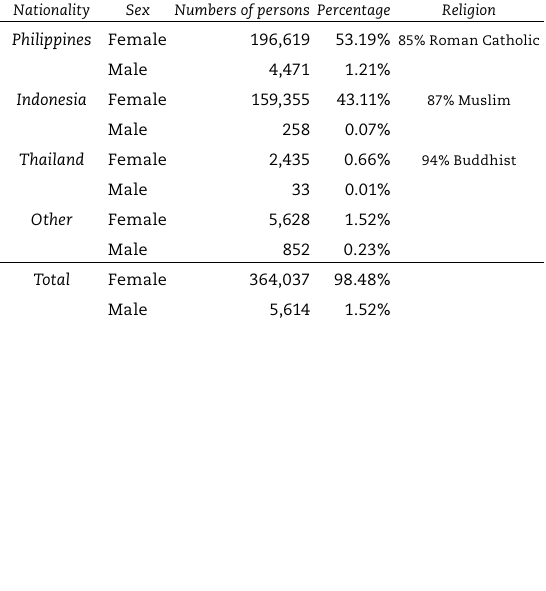
Table 1: Foreign Domestic workers by nationa- lity and sex, 2017 (The Government of Hong Kong SAR,